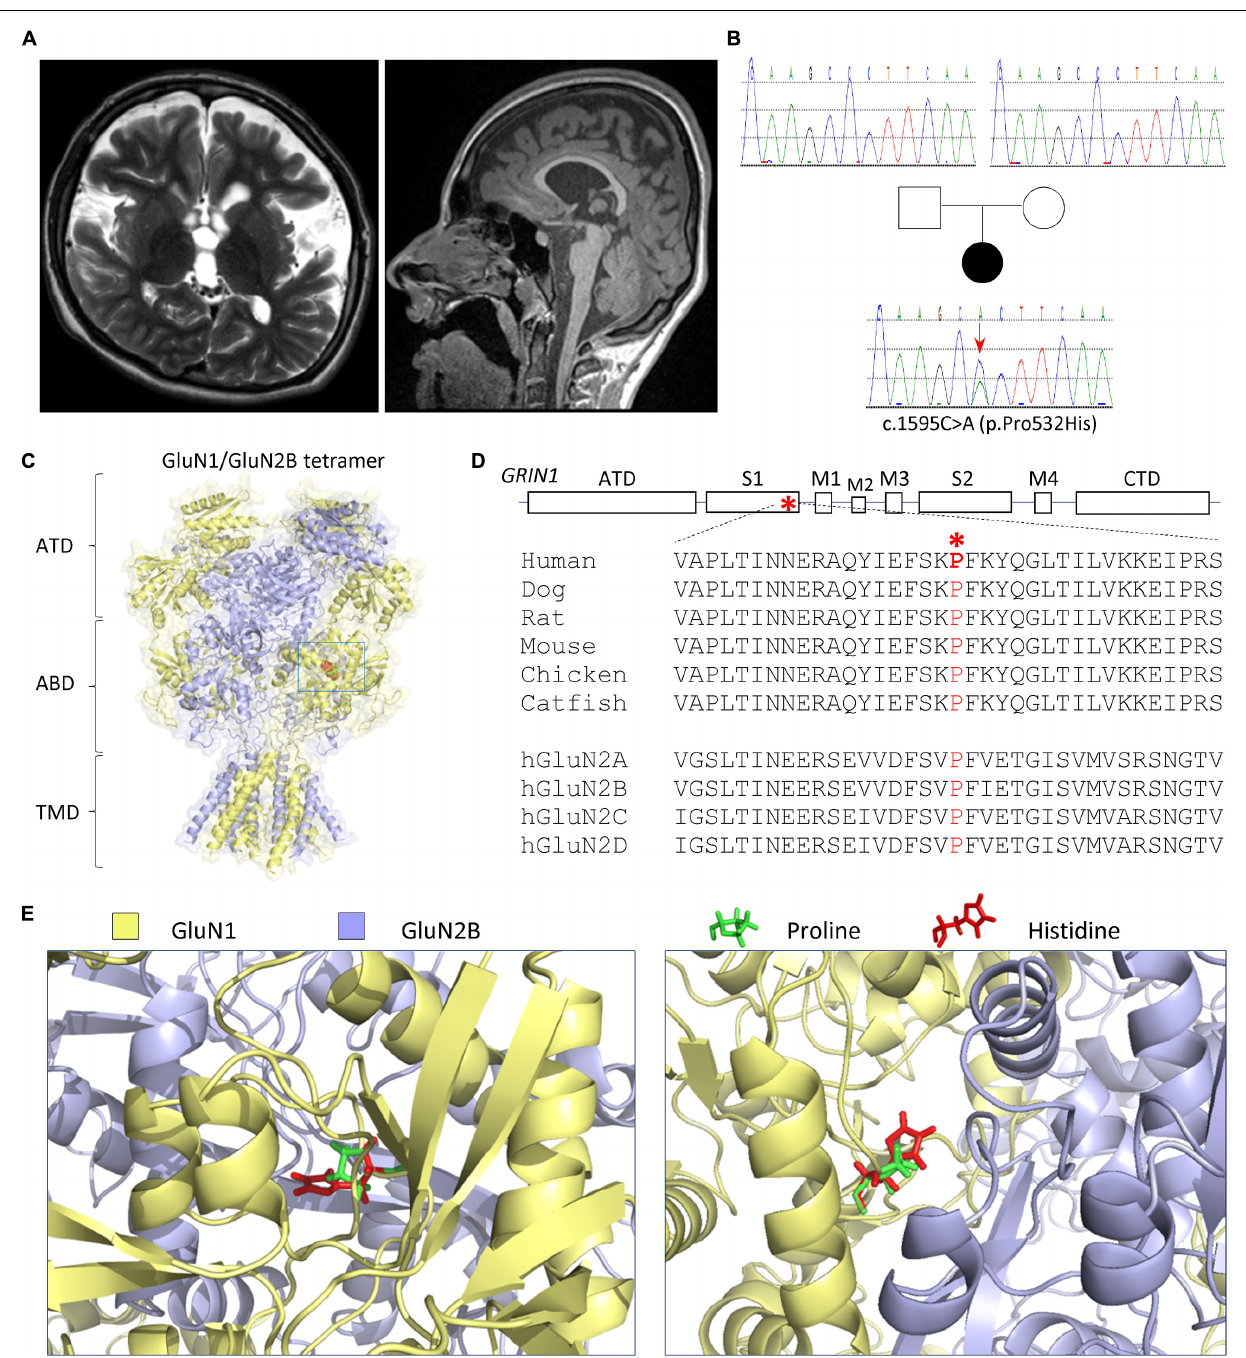
FIGURE 1 | Patient and variant information. (A) Brain MRI ( left panel : coronal T2; right panel : sagittal T1) at 5 years old showed thin corpus callosum, diffuse volume loss, enlarged lateral and third ventricles, and enlarged extra axial space, best seen over the frontal lobes with mild enlarged sulci. The brainstem, cerebellum, and posterior fossa appeared normal ( right panel ). (B) Pedigree and genotypes of a de novo GRIN1 (NM_007327) variant c.1595C > A (p.Pro532His). (C–E) The variation is located in the agonist-binding domain S1 highlighted in RED in a space-filled homology model of human GluN1/GluN2B receptor (Li et al., 2016; Chen et al., 2017b) built from the rat GluN1/GluN2B crystallographic data (PDB: 4PE5) (Karakas and Furukawa, 2014; Lee et al., 2014). (C) Schematic topology of a GluN1 subunit, where the position of the Pro532His is marked with a box and expanded below. NTD (also known as ATD) denotes the amino terminal domain, S1 and S2 interact to form the agonist-binding domain (ABD), M1–4 are the transmembrane domains, and CTD is the carboxyl terminal domain. (D) The proline residue at position 532 is highly conserved across vertebrate species and all GluN2 subunits. (E) The location in the agonist-binding domain S1 is expanded to show the position of the proline (in green) and variant histidine (in red). The left panel provides a side view, and the right panel provides a top view.